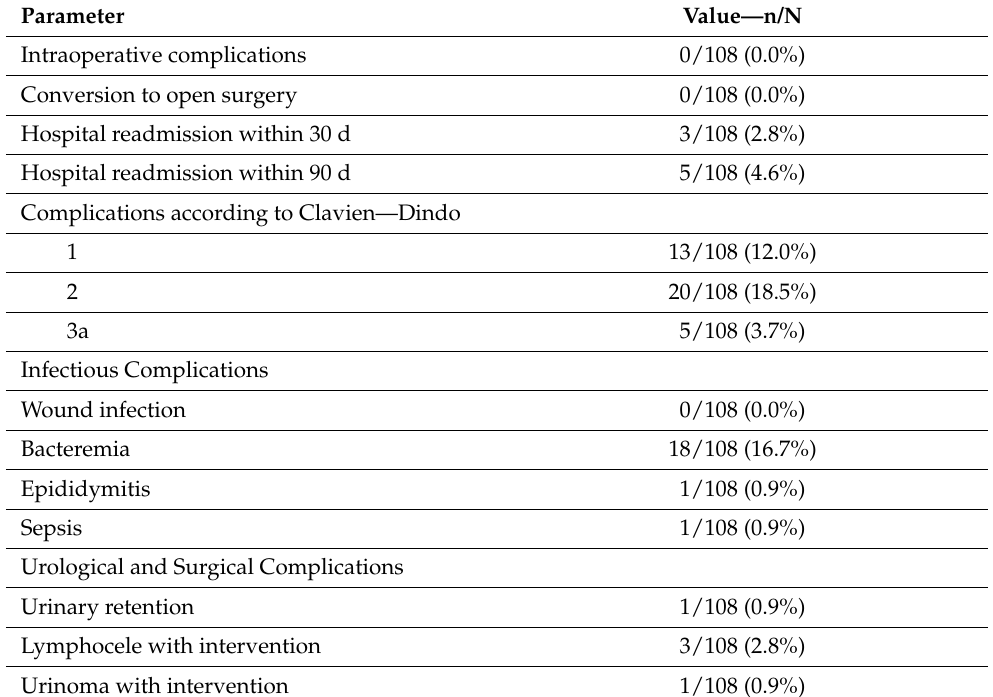
Table 3. Hospital readmission rates and adverse